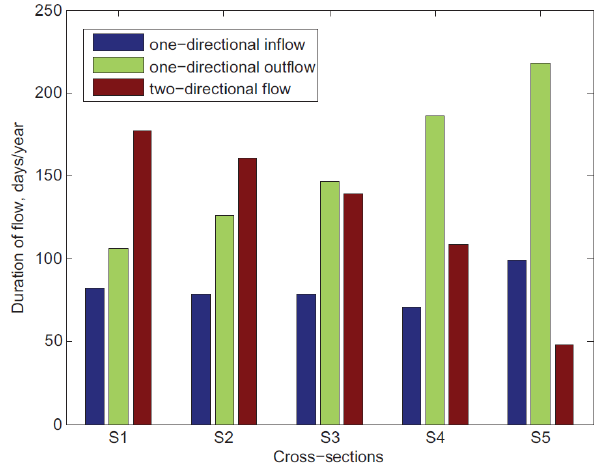
2 Figure 9: Average relative magnitude of flows in two-directional flow regime. 3 4 Fig. 9. Average relative magnitude of flows in two-directional flow